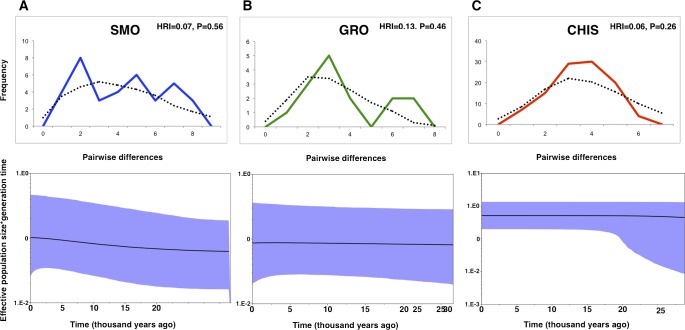
Mismatch distributions and Bayesian skyline plots for three geographic groups (A) Sierra Madre Oriental, SMO; (B) highlands of Guerrero, GRO; (C) highlands of Chiapas and Guatemala, CHIS) of L. rhami (mtDNA: CR, ATPase 6 and 8).In mismatch distributions, solid lines indicate the observed distributions of pairwise differences, and dotted lines represent simulated distributions under a model of population expansion. In Bayesian skyline plots, solid lines represent median estimates and shaded areas represent 95% confidence intervals.